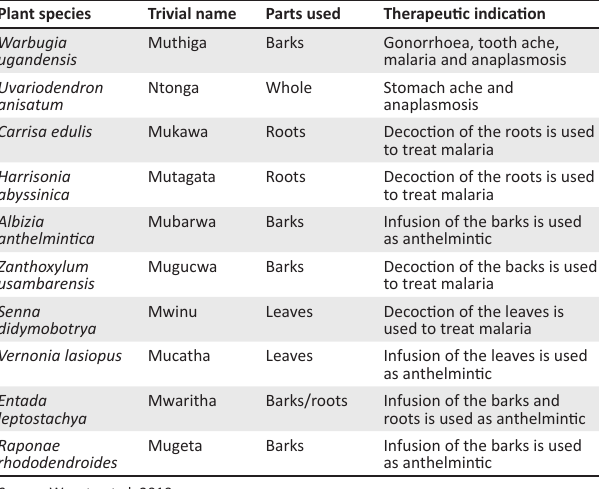
TABLE 1: Medicinal plant parts used and their therapeutic